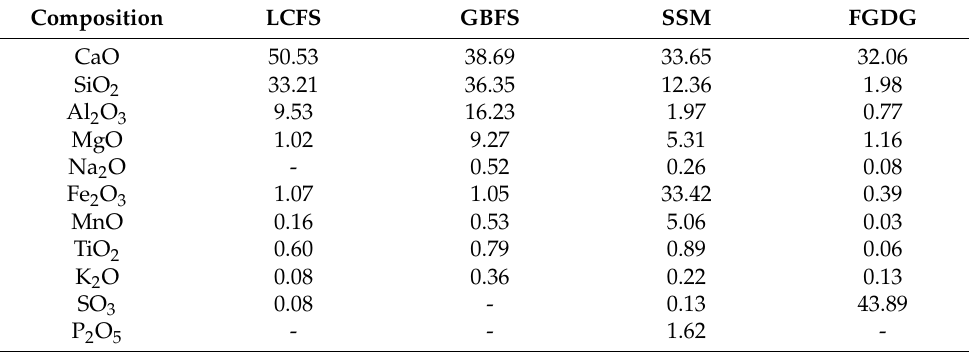
Table 1. Chemical composition of LCFS, GBFS, SSM and FGDG